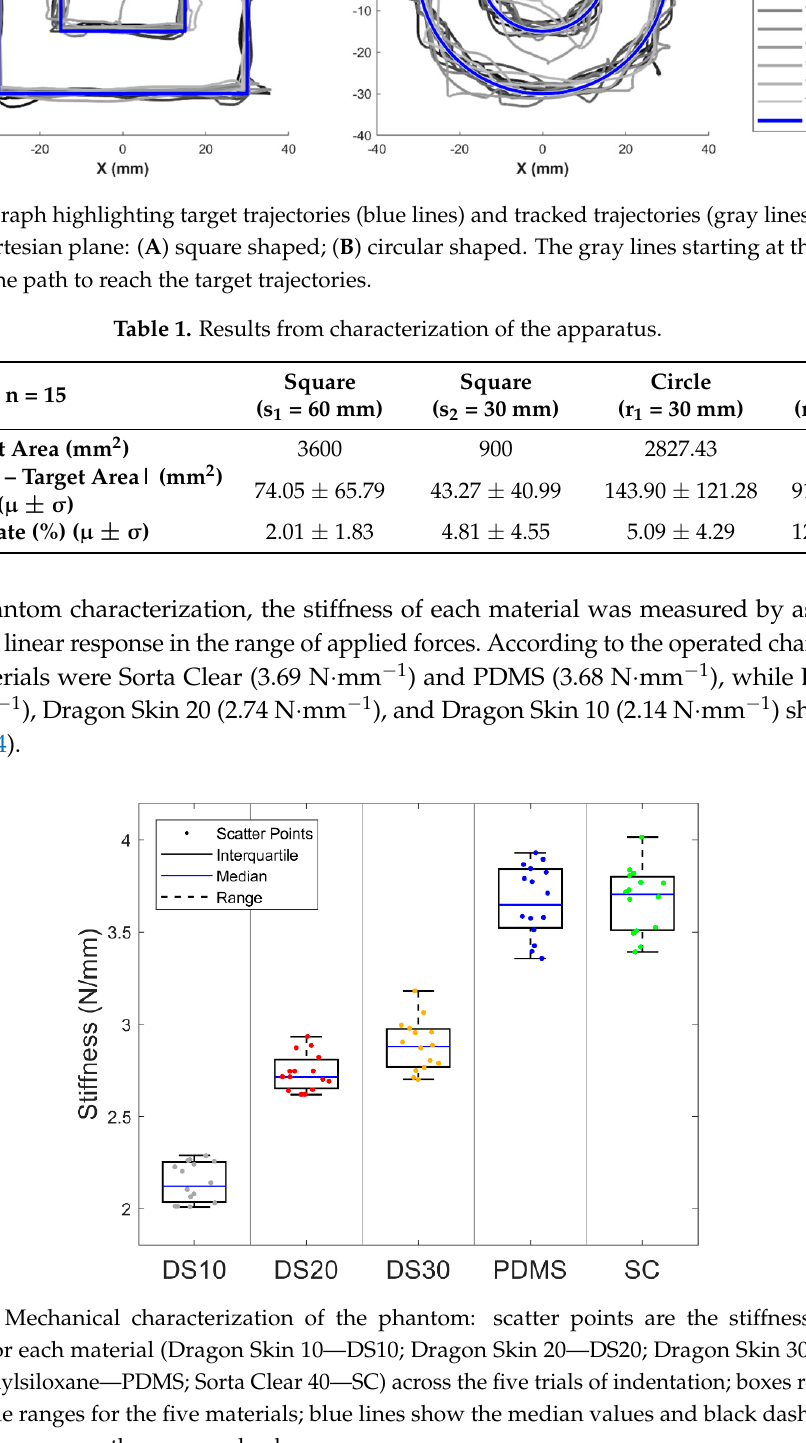
Figure 3. Example of responses given by a participant across an experimental session: colored circles mark the position of the inclusion set; black circles represent the position of the indenter when the subject pressed the key, and light blue line represents the trail of the probe on the phantom surface. Results show that an average of 63% and 60% of the inclusions were correctly perceived and declared within a tolerance of 10 mm to the nearest inclusion, for ILS and NILS experiments, respectively. In both cases, with a tolerance higher than the inclusion diameter (i.e., >10 mm), the rate of identified inclusions was slightly higher (Figure 4).